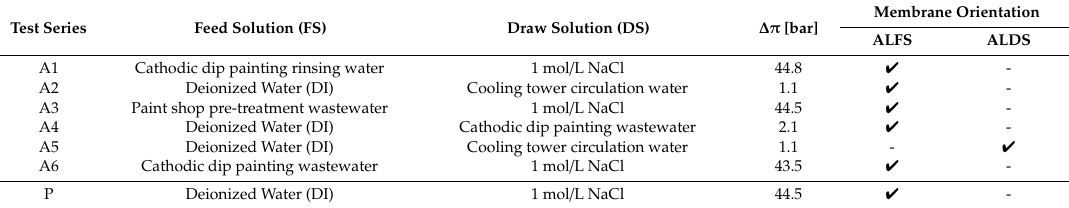
Table 1. FS and DS, osmotic pressure di ff erence ∆ π , and membrane orientation of the six experimental test series (A1–A6) and the performance tests